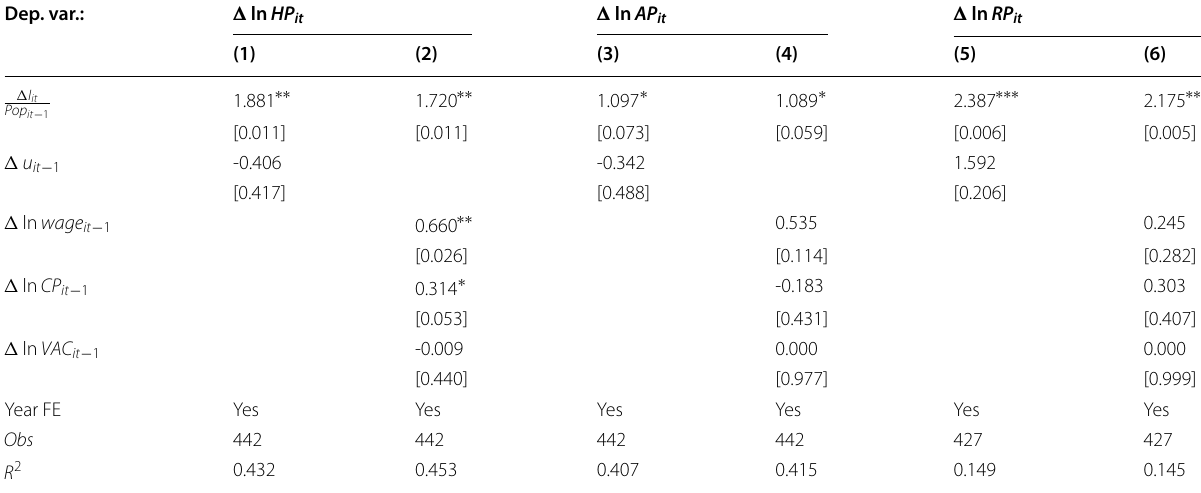
Table 6 Housing prices and immigration—cantons from 1998–2016: OLS regressions. Source: Own calculations based on data from Wüest Partner and Federal Statistical Office